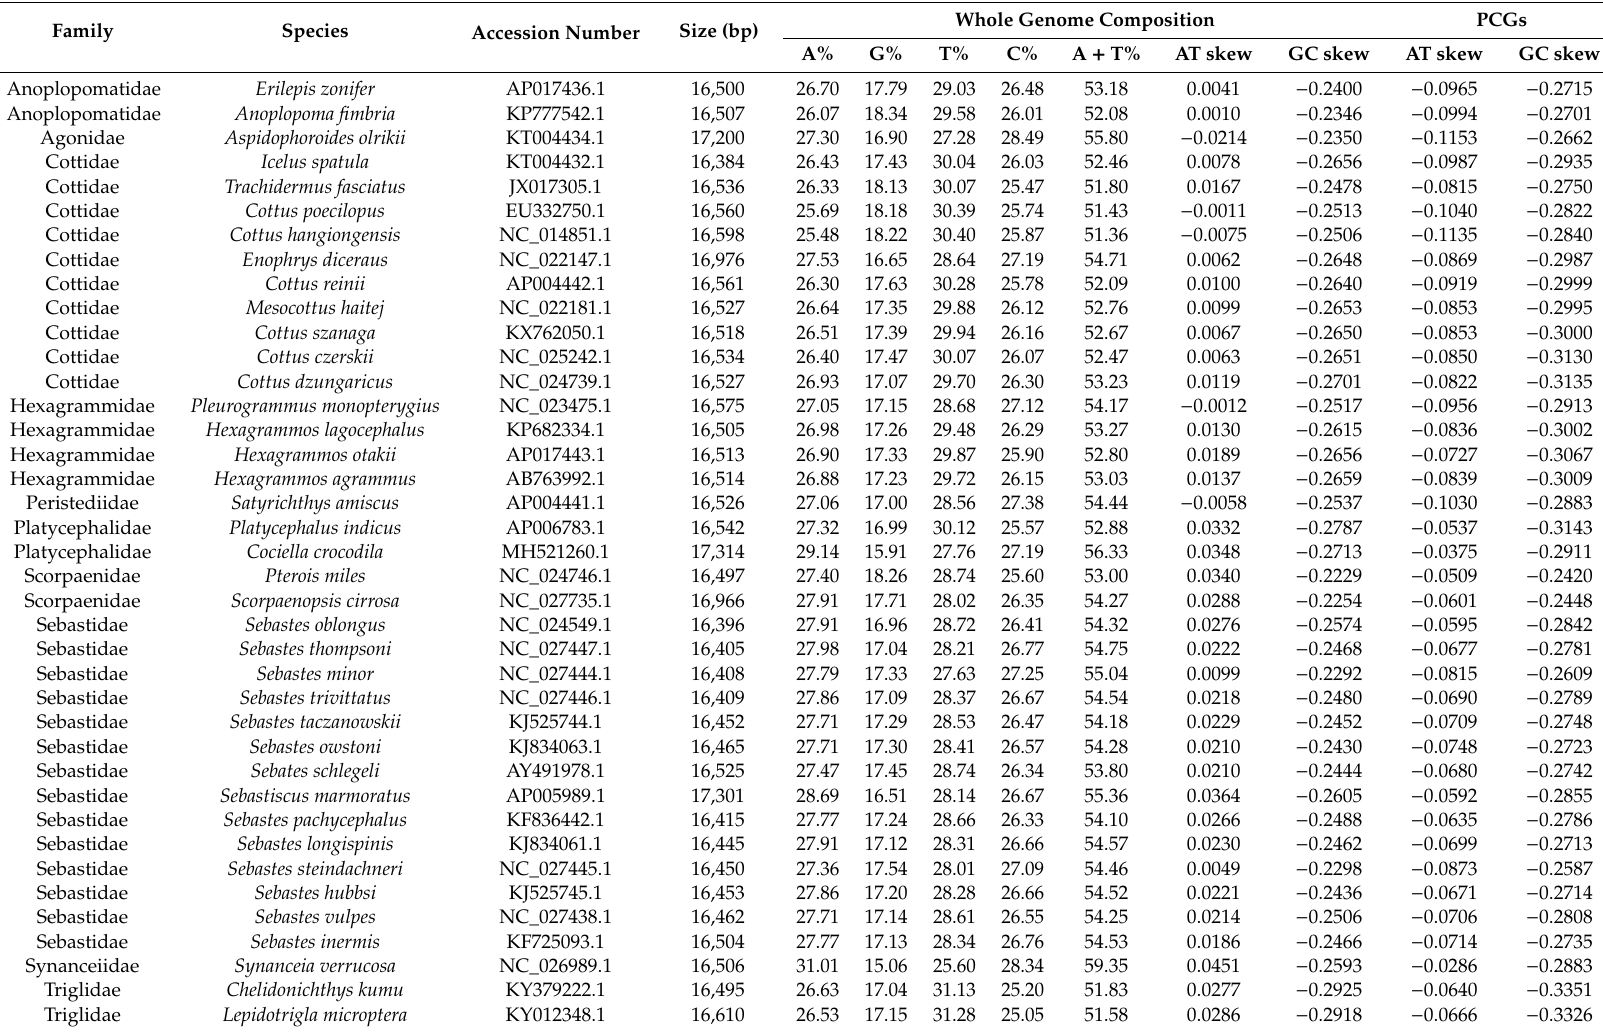
Table 1. Summary of the base composition and skewness of whole mitochondrial genomes and 13 protein-coding genes (PCGs) among 39 Scorpaeniformes